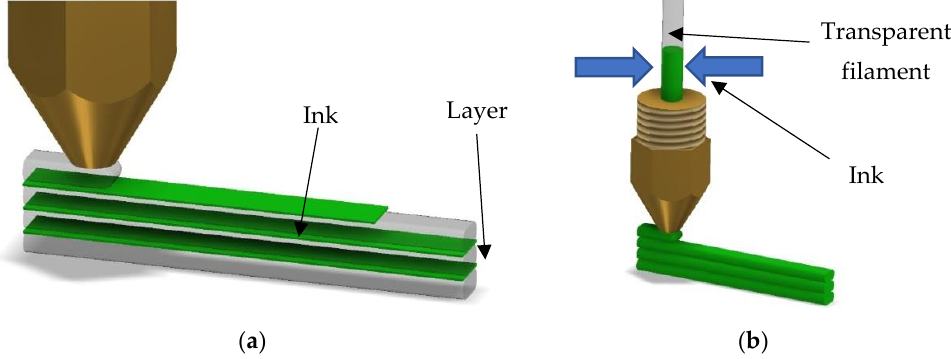
Figure 2. Main in-process possibilities for reproducing colours in 3D MEX processes: ( a ) layer colouring; ( b ) filament colouring.